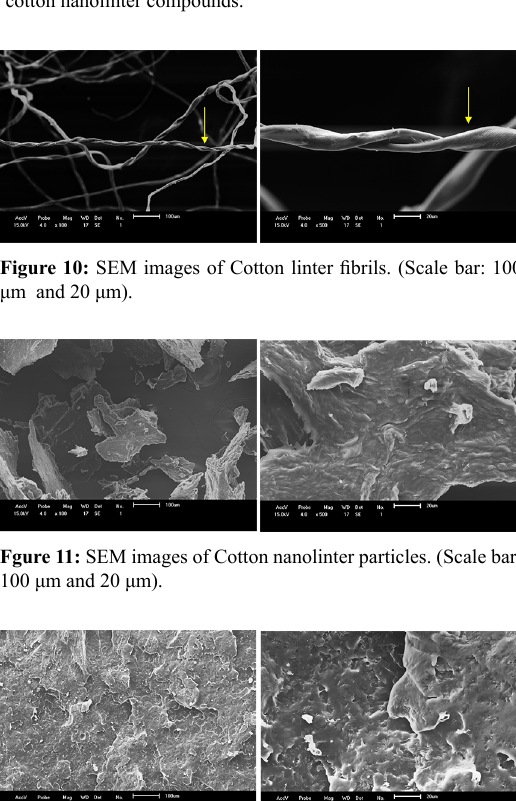
Figure 9: HDT measurements of PCL, PCL/cotton linter and PCL/ cotton nanolinter compounds.